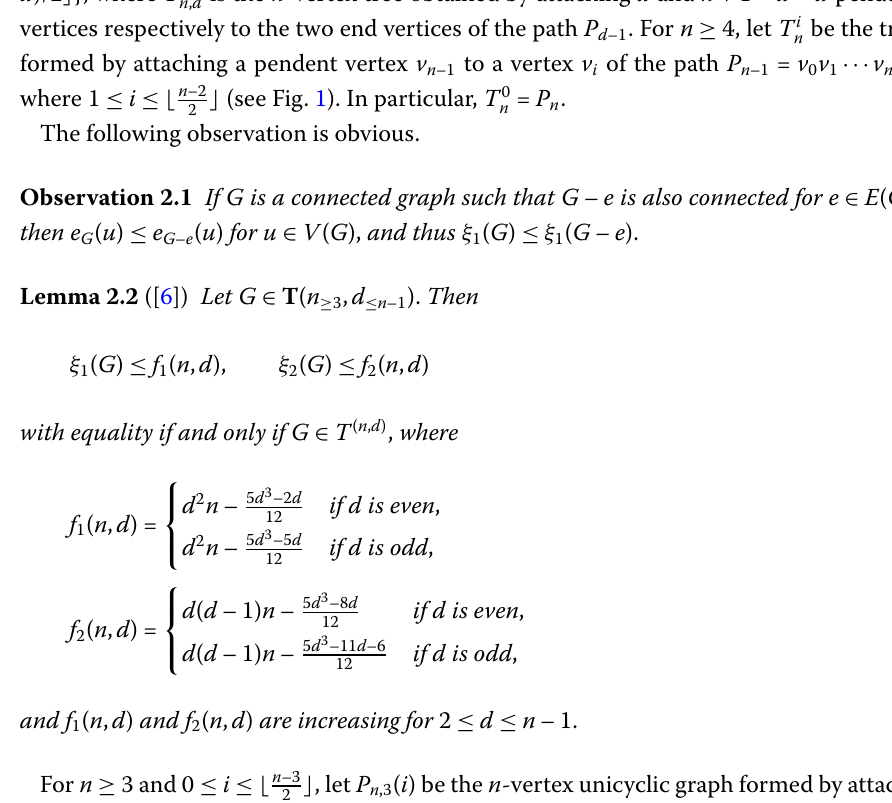
B ( n ≥ n , d ≤ d )) be the set of n -vertex trees (res. unicyclic graphs, bicyclic graphs) with the 0 0 diameter d , where n ≥ n 0 and d ≤ d 0